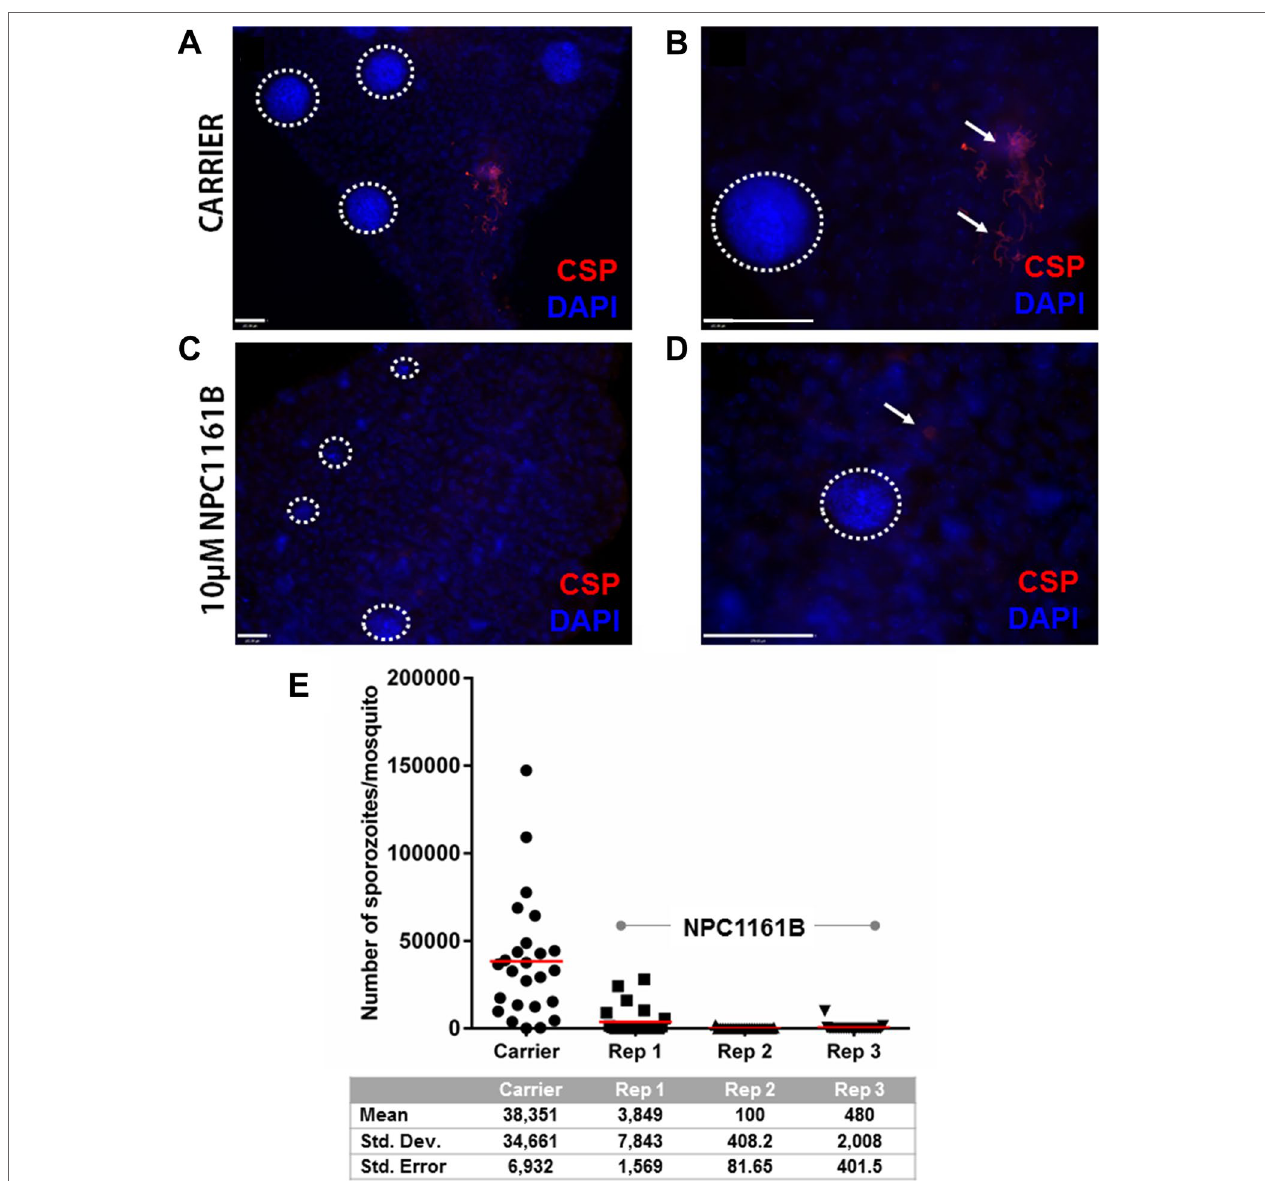
FIGURE 2 | NPC1161B-derived metabolites block sporozoite development. Mosquitoes were given carrier solvent alone (A-B) or NPC1161B (10 µM) (C-D) at day 4 post-infection. Midguts were dissected on day 11 post-infection. The midguts were probed with anti- P. falciparum circumsporozoite protein to identify fully formed sporozoites and stained with DAPI to permit visualization of individual sporozoite segmentation. The dotted white lines demarcate the boundaries of oocysts captured in the field of view. The white arrows point to a group of sporozoites that were released from a burst oocyst and found fixed to the outside of the midgut. (E) NPC1161B (10 µM) or carrier solvent was administered to mosquitoes at day 4 post-infection; salivary glands were dissected, and sporozoites were counted at day 14 post-infection. The reduction in sporozoite number for each replicate of NPC1161B treatment (N = 25) as compared to the carrier solvent treatment (N = 25) was found to be statistically significant by ANOVA ( P <